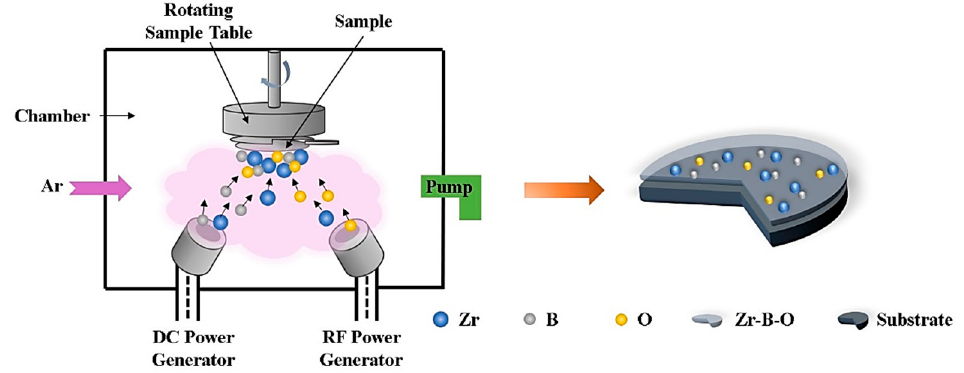
Figure 1. Schematic diagram of preparation of Zr-B-O nanocomposite films by magnetron co-sputtering.